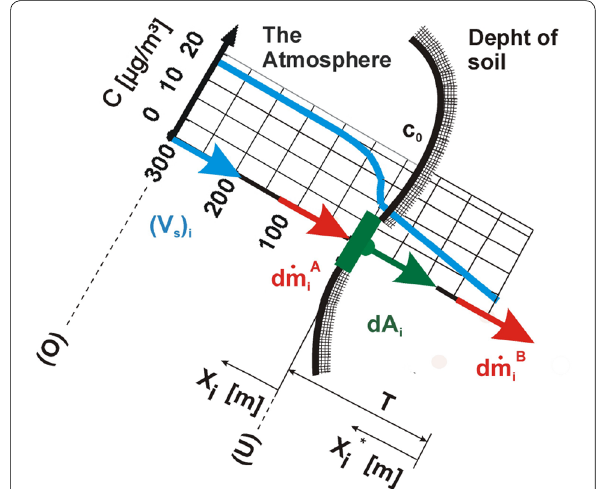
Fig. 1 General validity of Berljand’s boundary